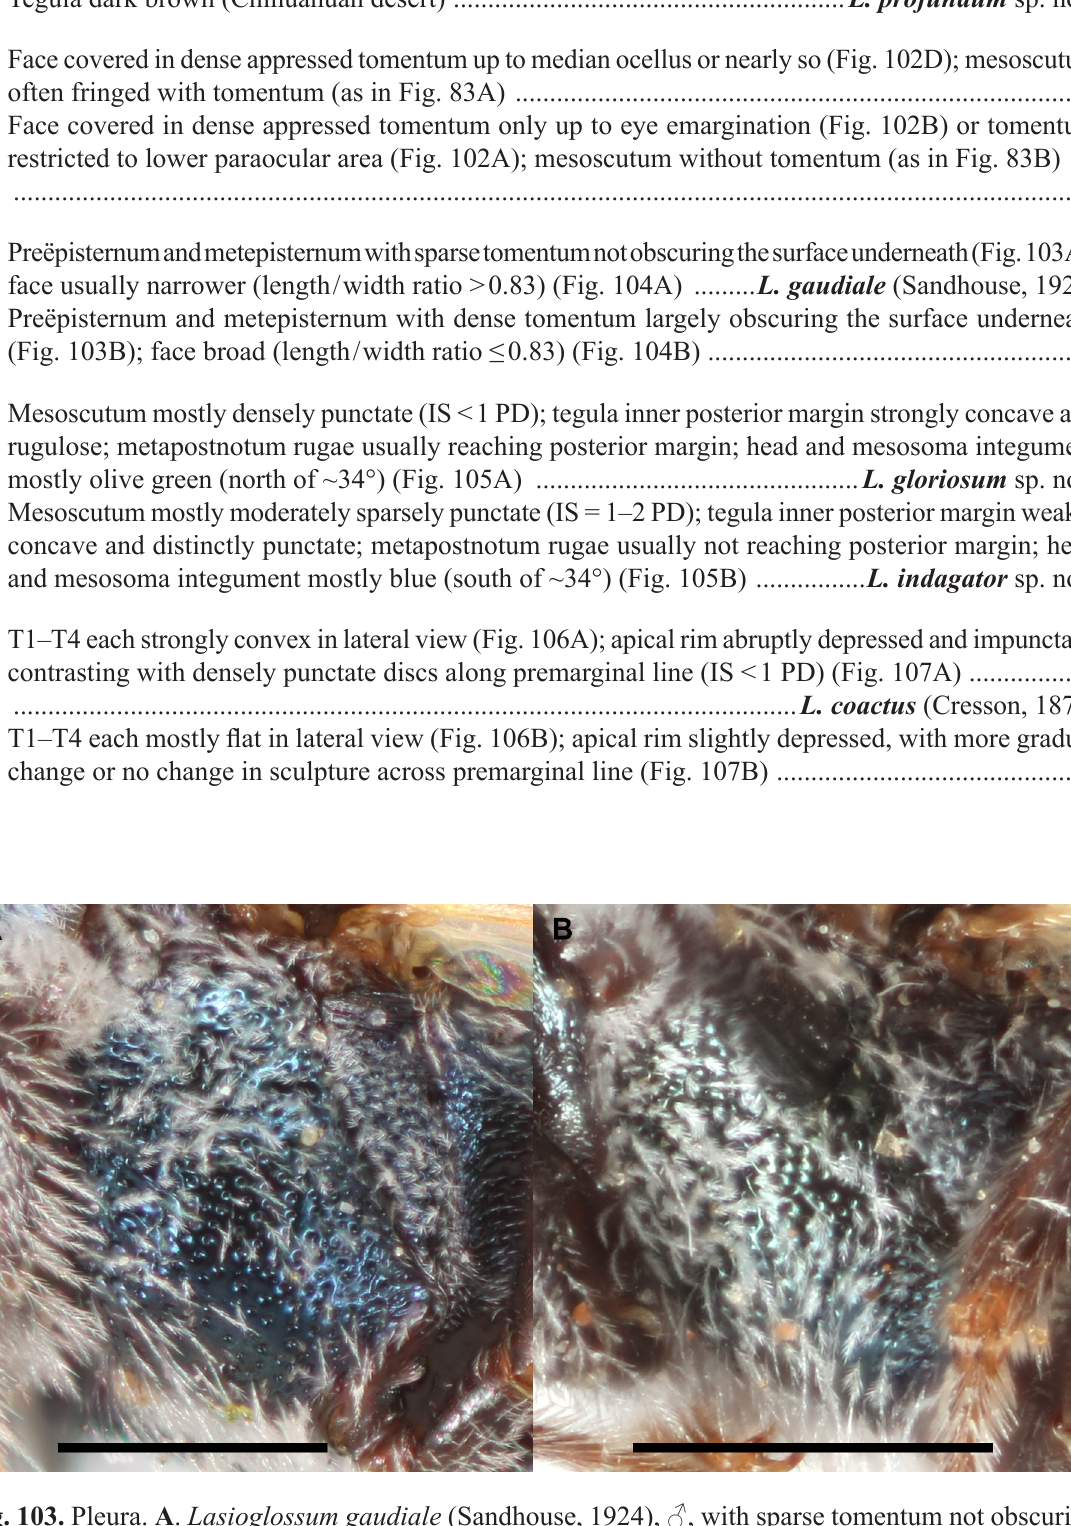
Fig. 103. Pleura. A . Lasioglossum gaudiale (Sandhouse, 1924), ♂, with sparse tomentum not obscuring the surface. B . L. gloriosum sp. nov., ♂, with dense tomentum obscuring the surface on preëpisternum and metepisternum. Scale bars = 0.5